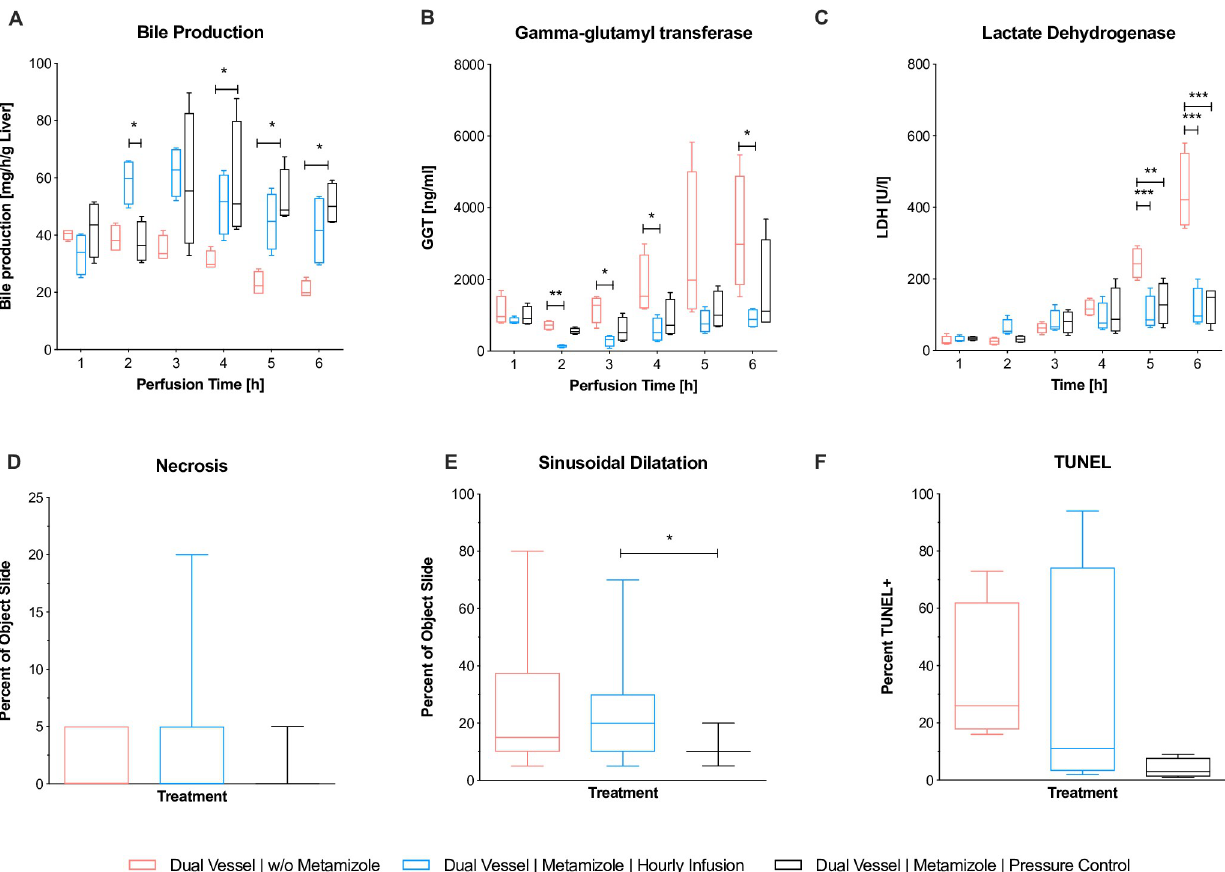
Fig 3. Comparison of dNEVLP groups 2. Comparison of the three dNEVLP groups: (A) amount of bile production, (B) bile gamma-glutamyl transferase, (C) lactate dehydrogenase within bile, (D) liver parenchyma necrosis, (E) liver parenchyma sinusoidal dilatation, (F) bile duct necrosis in TUNEL staining. � indicates p � 0.05, �� p � 0.01 and ��� p = 0.001. Data shown as median and interquartile range.